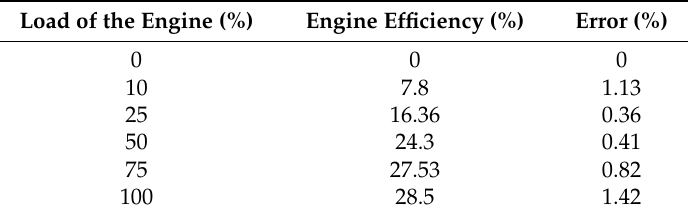
Table 1. Engine simulation results and errors.